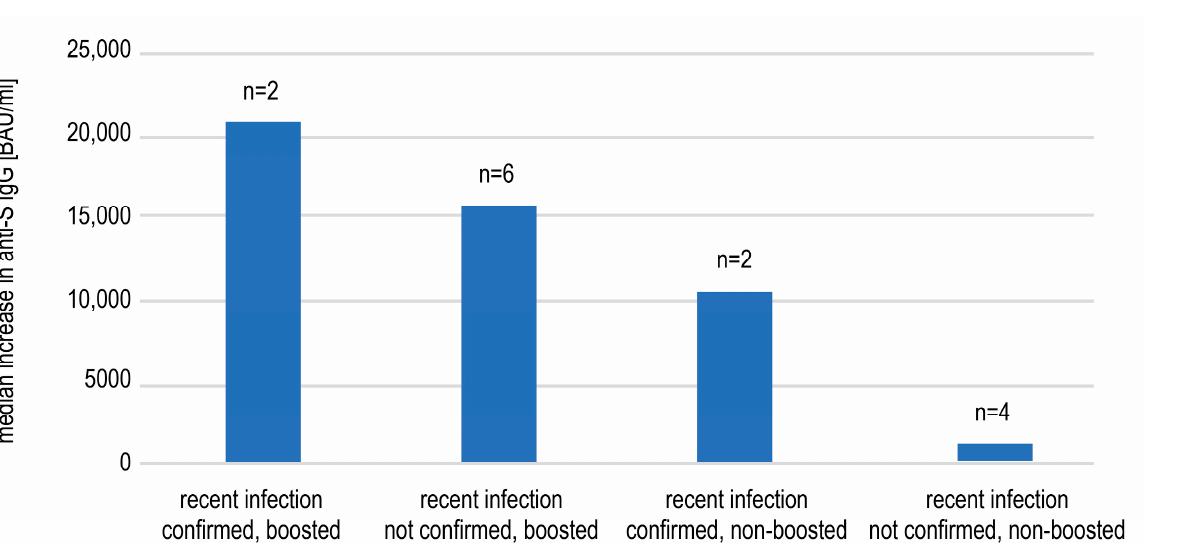
Figure 4. The median antibody concentrations and interquartile ranges on days 240 and 360 in sub- groups defined by the recent infection and booster status. A statistically significant rise (Wilcoxon test) between those two timepoints was only seen in the subgroups of boosted subjects.